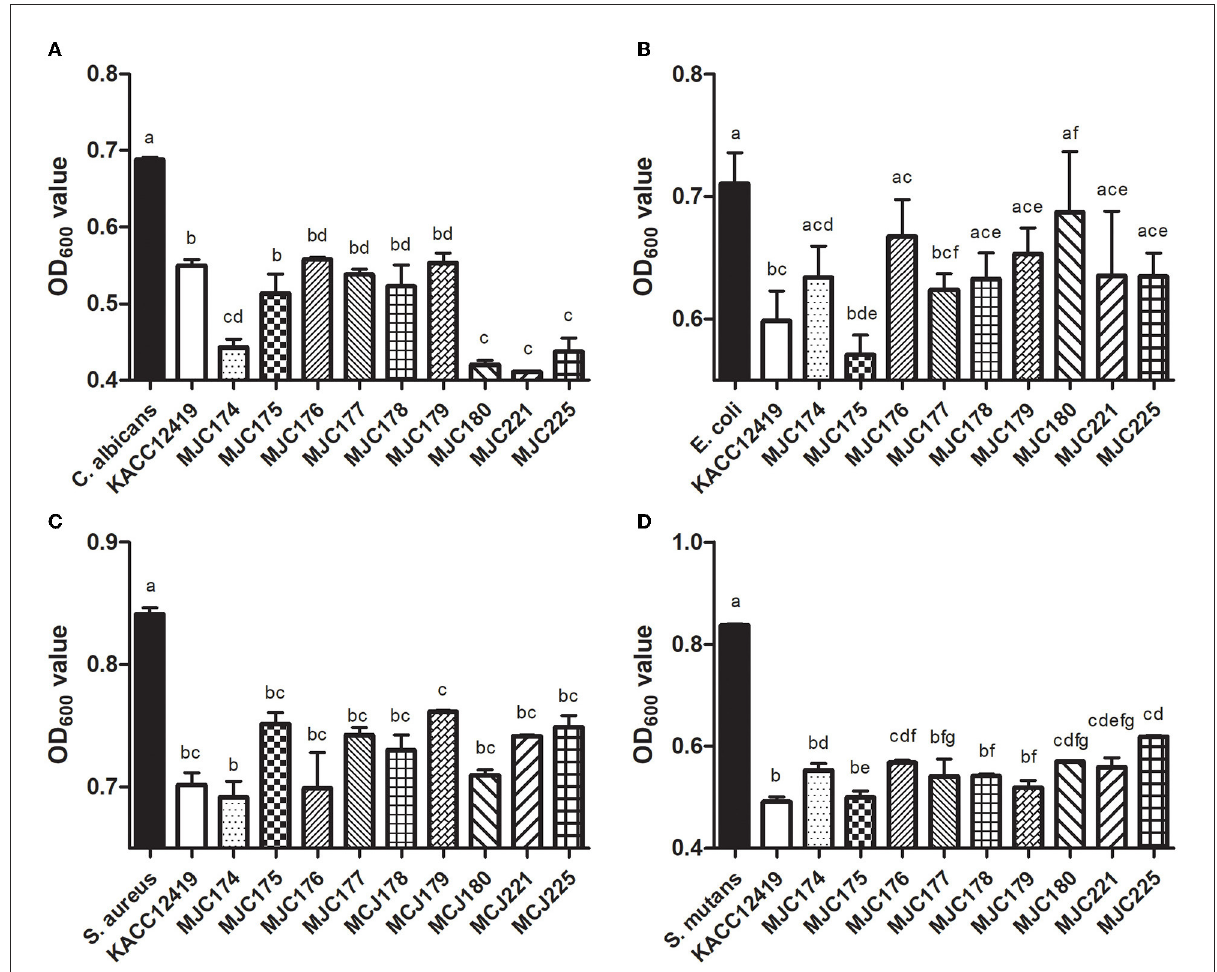
FIGURE2 Antimicrobial activity of nine isolates against different pathogenic microorganisms. The supernatant of each isolate was used against (A) Candida albicans , (B) Escherichia coli , (C) Staphylococcus aureus , and (D) Streptococcus mutans . Lowercase letters indicate significant differences ( p < 0.05) between strains. KACC; L. acidophilus